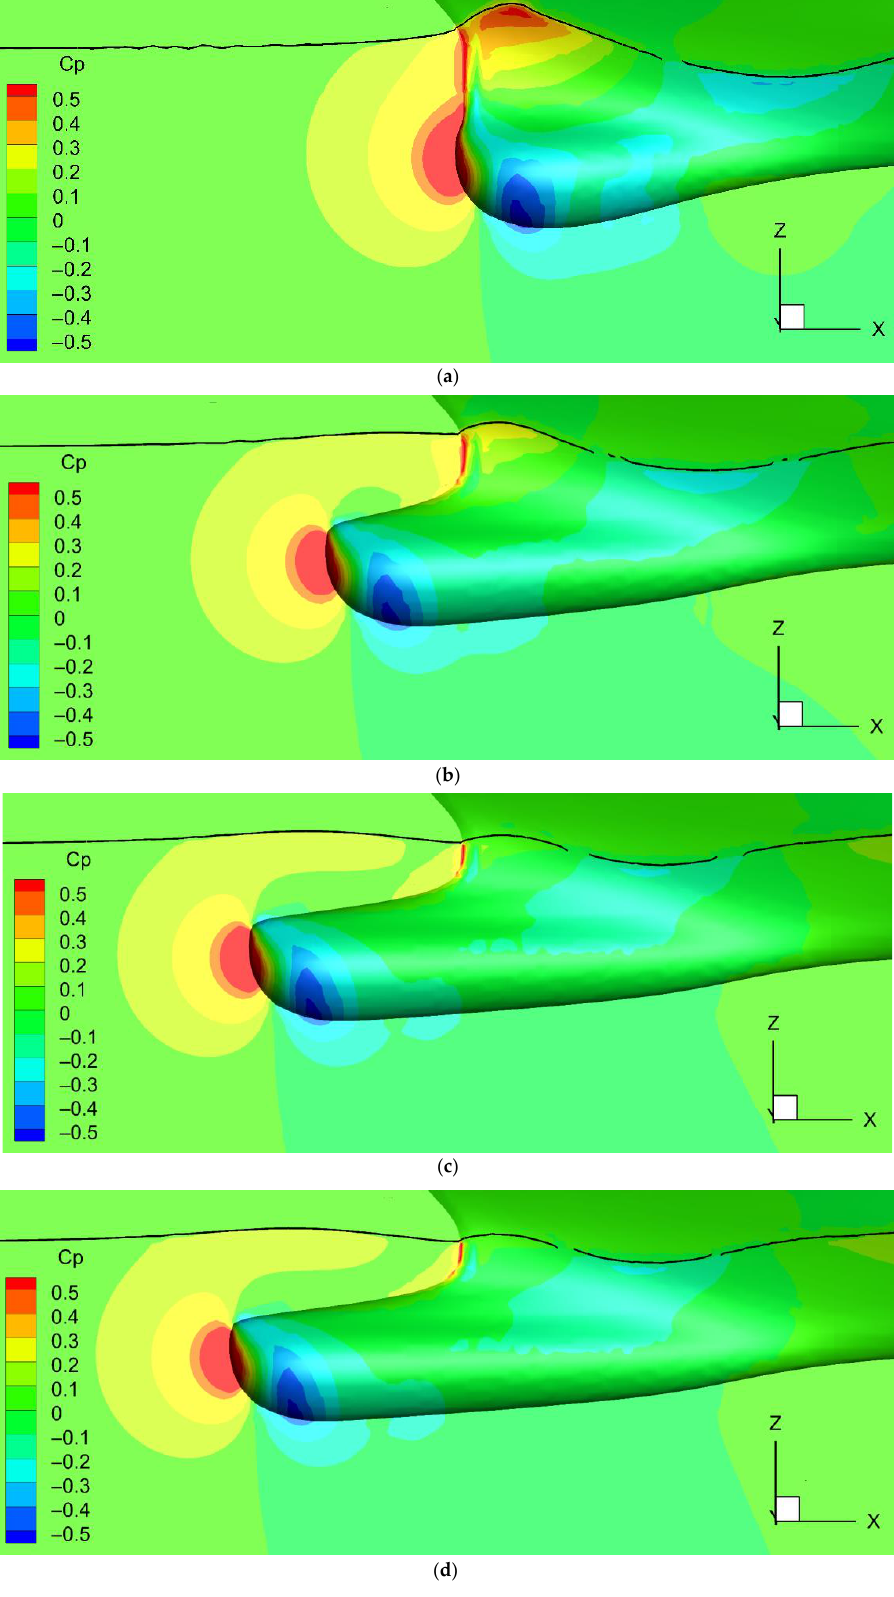
Figure 13. Pressure coefficient ( Cp ) distribution around the ship ’s bow and sonar dome: ( a ) F0; ( b ) F0.14; ( c ) F0.225; ( d ) F0.24. The black line is the free surface profile on middle plane and ship hull surface.